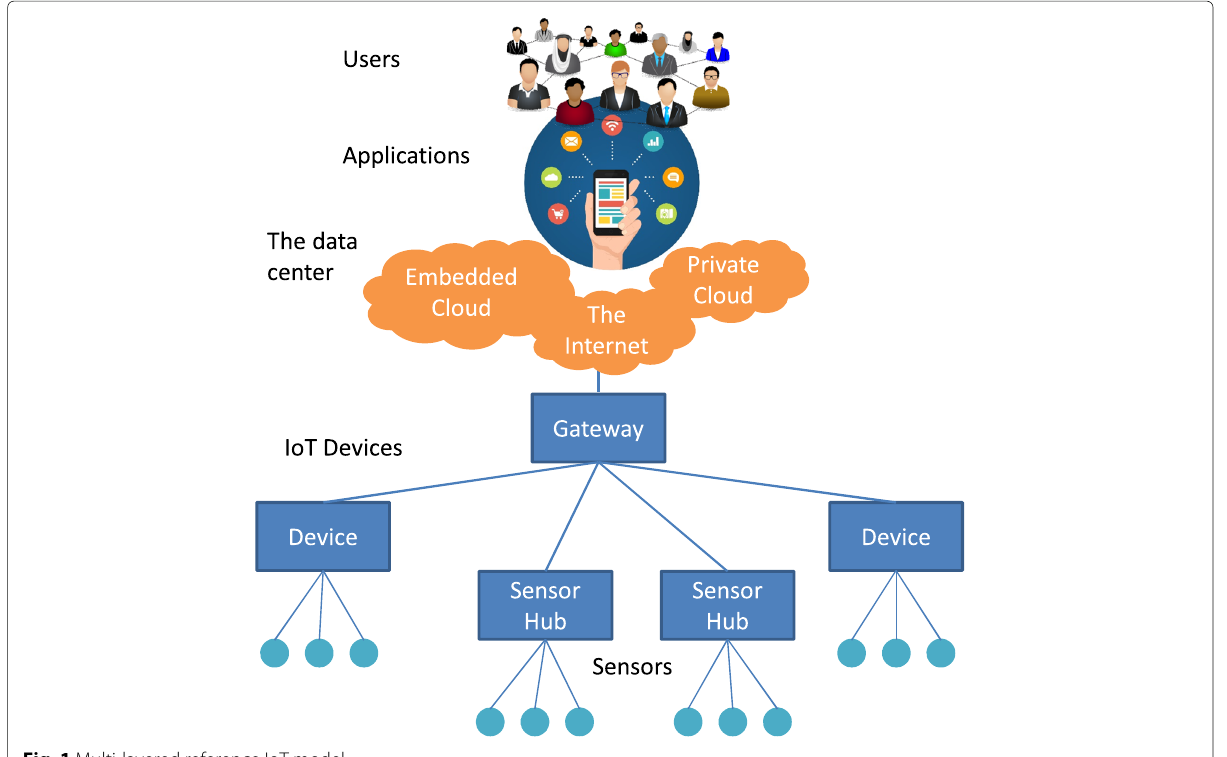
Fig. 1 Multi-layered reference IoT